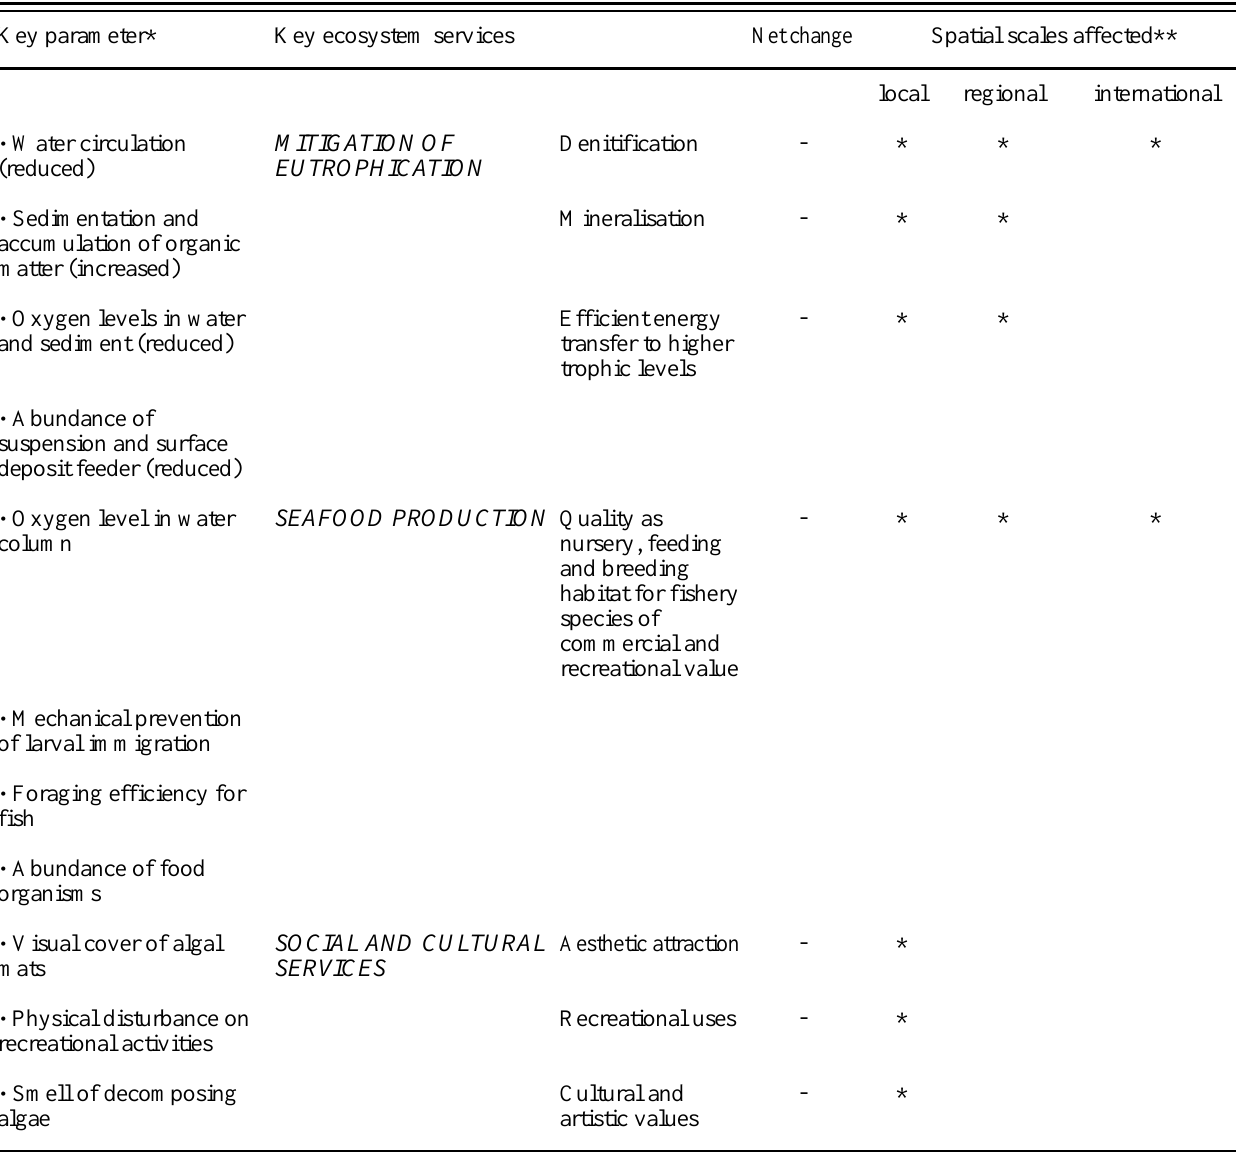
Table 1 . Net changes in the provision of ecosystem services after phase shift from unvegetated to algal mat covered shallow soft bottom habitats on the Swedish west coast. Key parameter* Key ecosystem